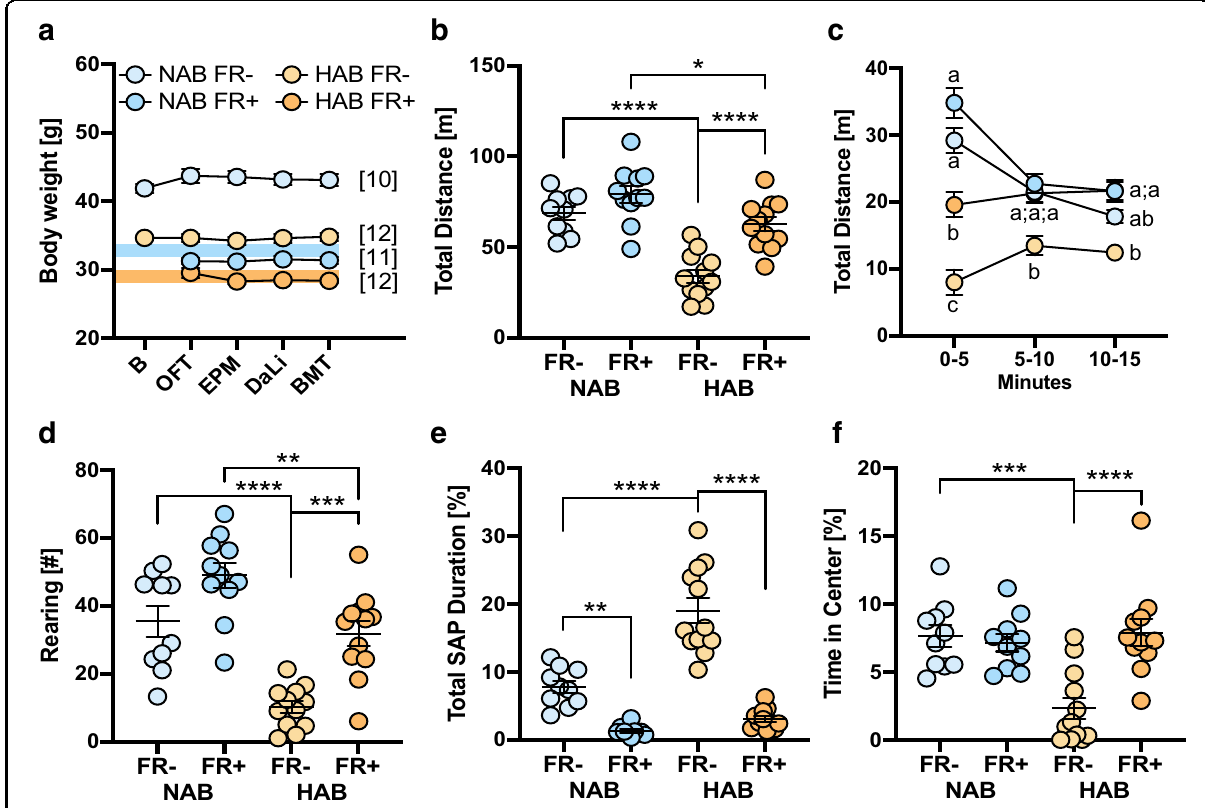
Fig. 1 Food restriction procedure and open fi eld test (OFT). a HAB and NAB mice were either food restricted (FR + ) to reach 85% (shaded area) of their original body weight (baseline, B) or continued to be fed ad libitum (FR − ). The body weight remained fairly stable throughout the entire test battery comprised by open fi eld test (OFT), elevated plus maze test (EPM), dark – light transition task (DaLi), and beetle mania test (BMT), with at least 7 days of recovery between two subsequent tasks. Numbers in brackets: sample sizes. b – f Behavioral performance during a 15-min exposure to the OFT. Mean ± SEM with individual data. * p < 0.05, ** p < 0.01, *** p < 0.001, **** p < 0.0001 (two-way ANOVA followed by Tukey ’ s post hoc test); in c , data points without shared letters are statistically signi fi cantly different ( p < 0.05; three-way ANOVA for repeated measures, followed by Tukey ’ s post hoc